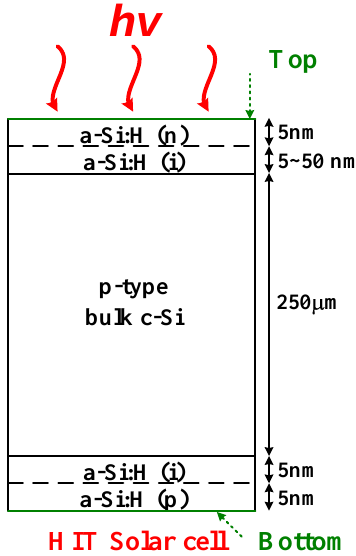
Figure 1. Schematic structure of an HIT solar cell with p-type crystalline Si. The a-Si:H(i) layer can reduce the surface recombination rate.